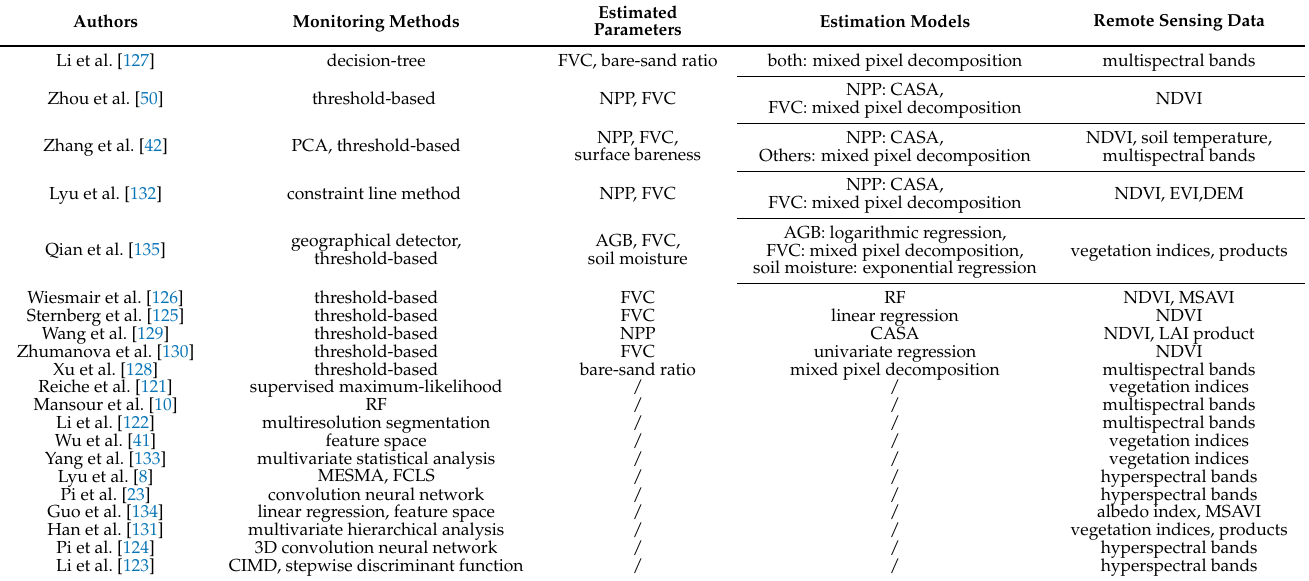
Table 6. Detailed information on the involved monitoring studies for grassland